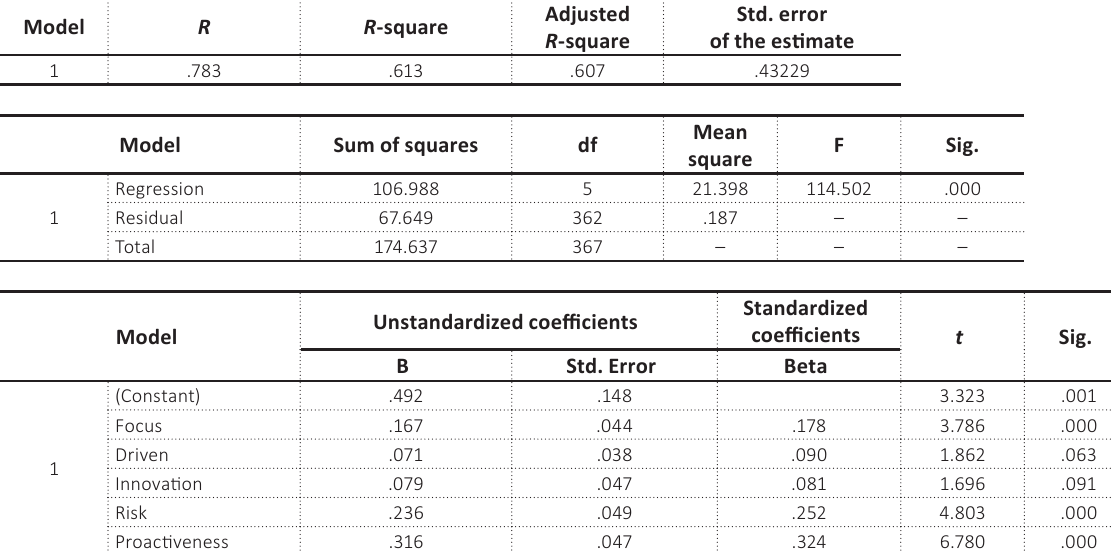
Table 3. Model summary, ANOVA, and coefficients of main hypothesis Model